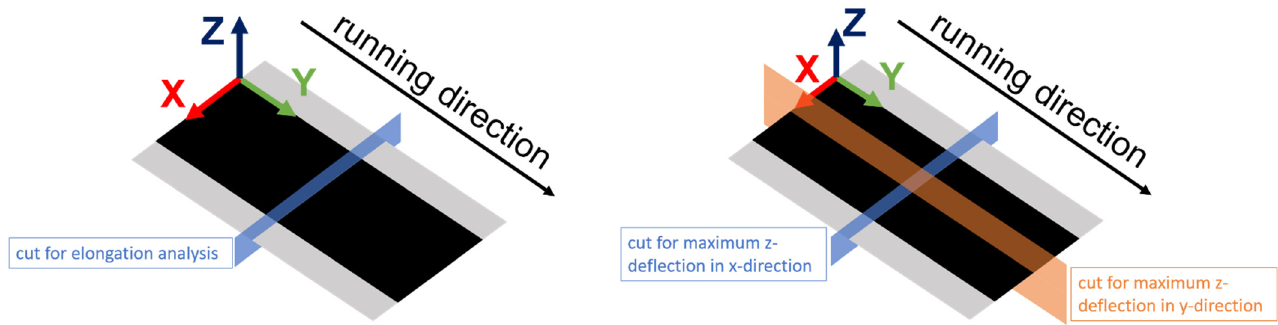
Figure 1. The coordinate system for GOM elongation ( left ) and deflection ( right ) analysis .